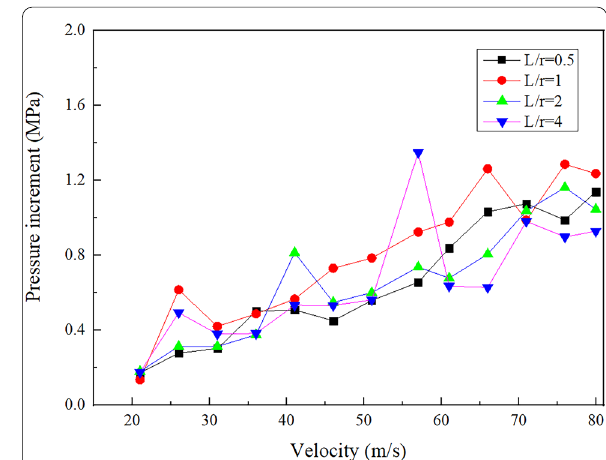
Figure 9 Pressure increment measured at nozzle